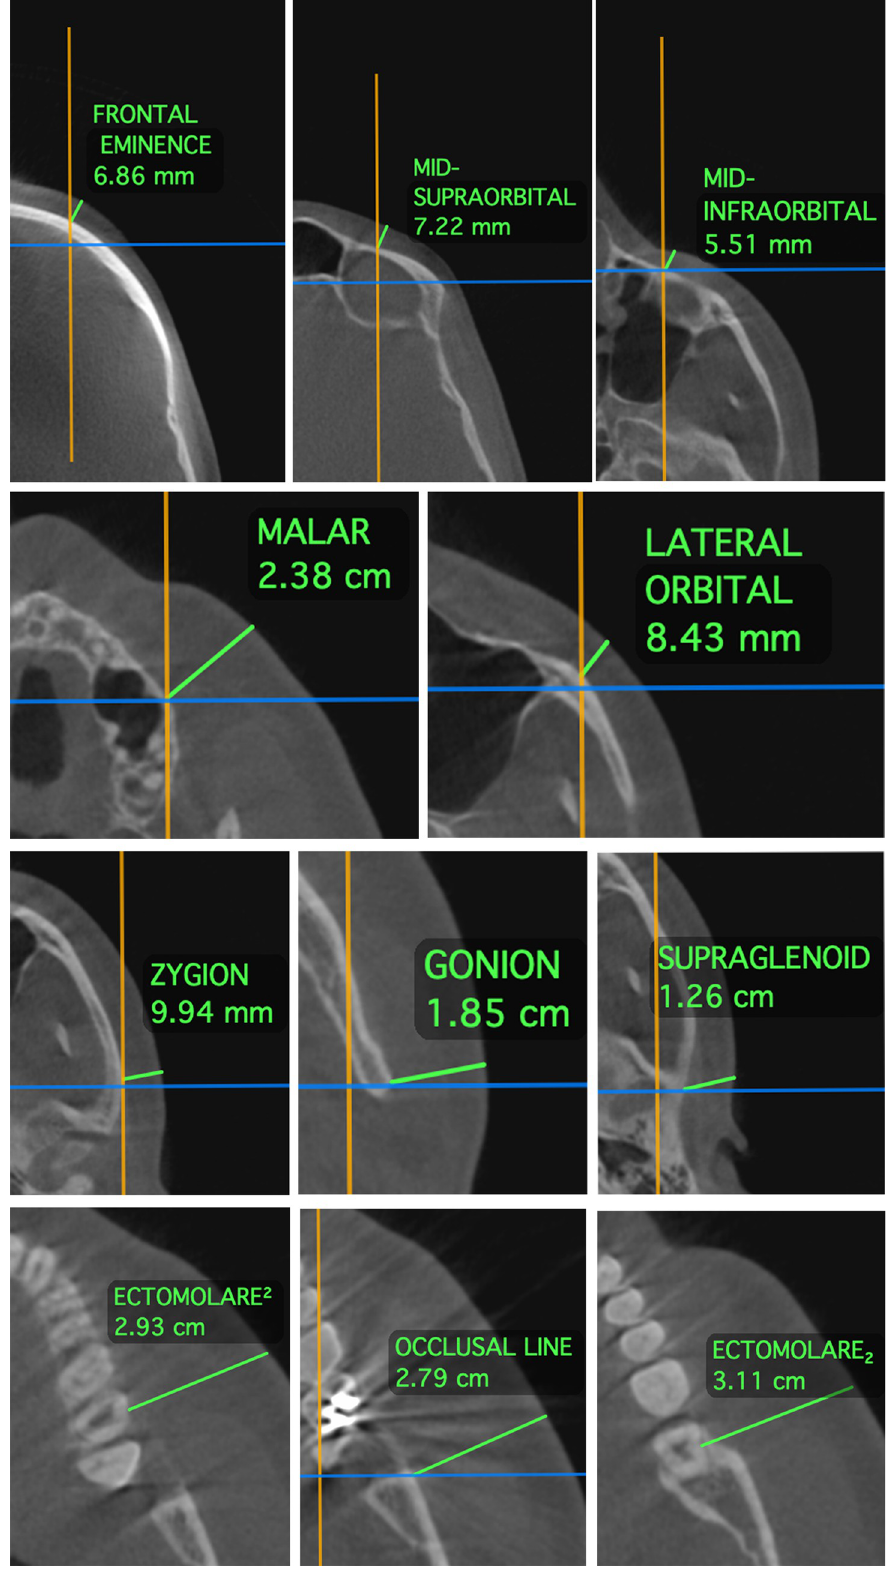
Fig 3. Bilateral landmarks